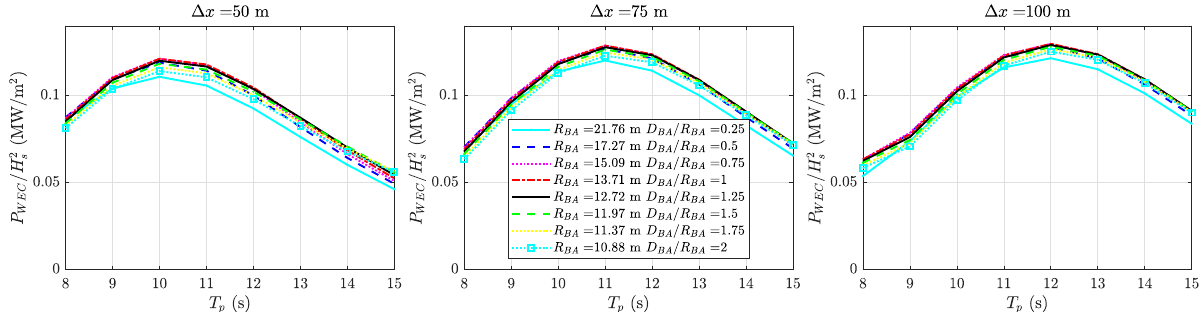
Figure 4. Power (scaled to wave height) generation as a function of peak period for varied R BA and D BA values (as per legend). Left to right: varied separation